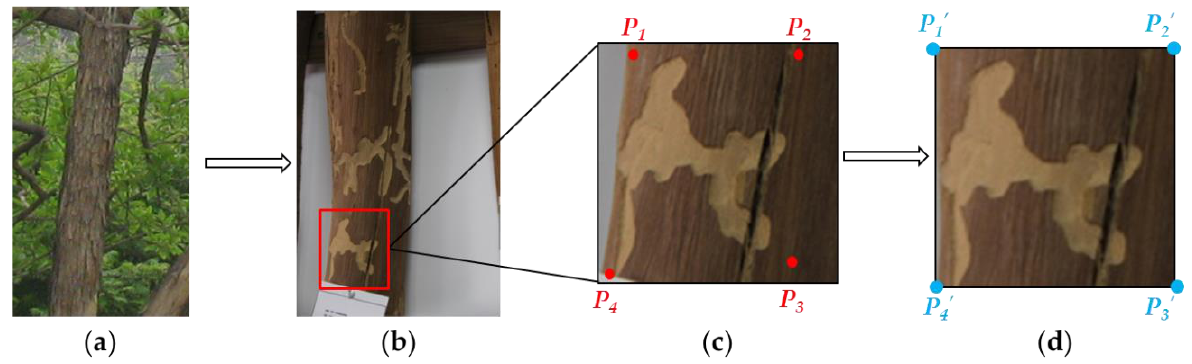
Figure 2. Image correction: ( a ) The complete trunk; ( b ) The trunk after bark removal; ( c ) The selected position points; ( d ) The corrected image and corresponding points.